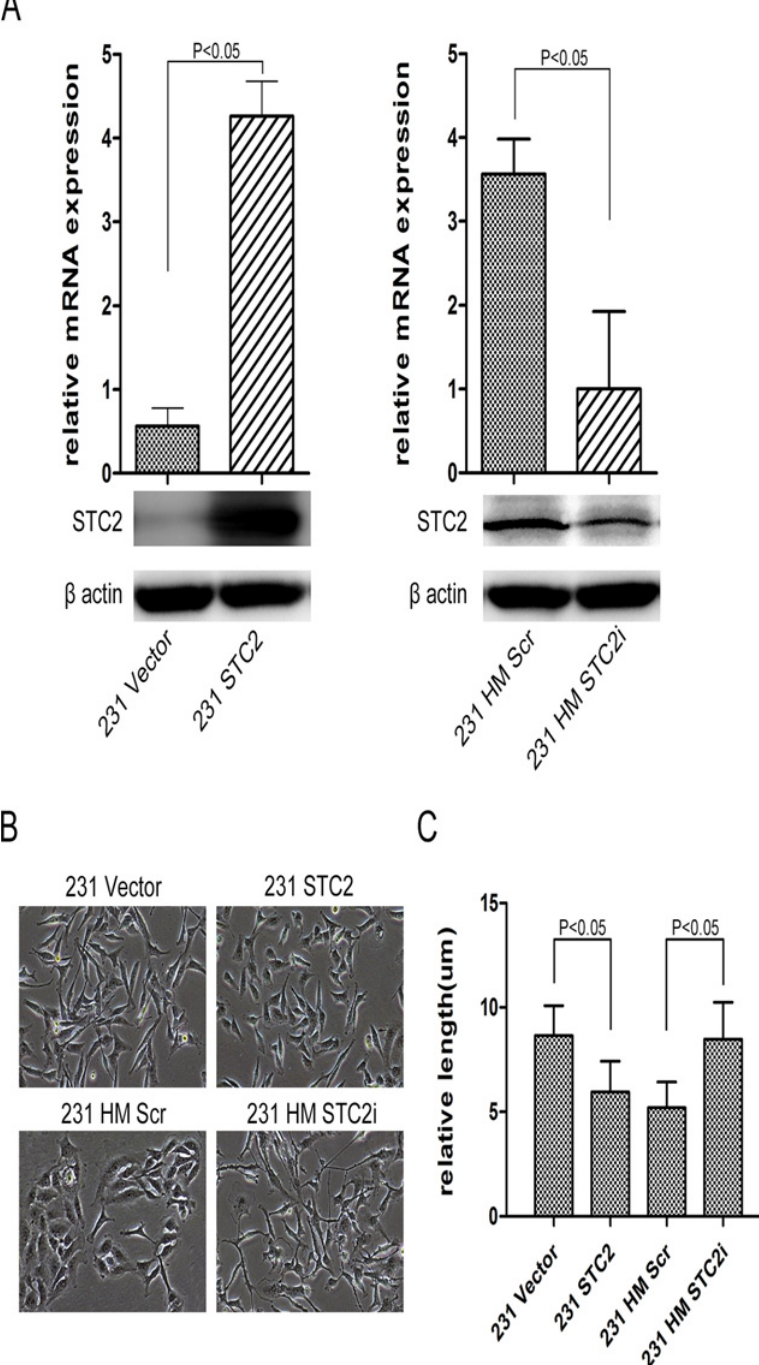
Fig 1. STC2 maintains breast cancer cell morphology. A , Analyses of STC2 by Western blotting and realtime-PCR in constructed cells (P < 0.05). Error bars = 95% confidence intervals (CIs). B , Cell morphology. Ectopic overexpression of STC2 in 231 cells changed the cell spindle phenotype, and displayed as frizzle phenotype. 231 HM cells losing STC2 expression displayed an elongated mesenchymal-like morphology with scattered distribution. C , Measurement of the relative length of the cells according to Fig 1. B (P < 0.05). Error bars = 95% CIs.